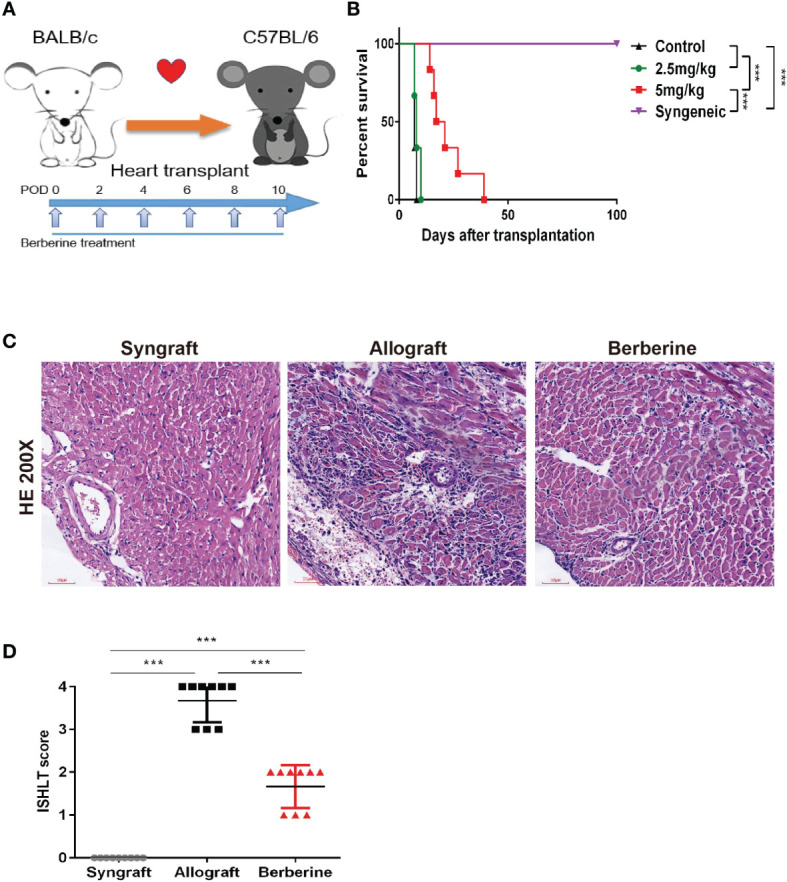
The effect of berberine on acute rejection of fully mismatched cardiac allografts. (A) Treatment schedule for berberine. BALB/c cardiac grafts were transplanted into C57BL/6 recipients at POD 0. C57BL/6 recipients were treated with normal saline, 2.5 mg/kg berberine, or 5 mg/kg of berberine i.p. on the days indicated by arrows. (B) Survival of cardiac allografts in berberine-treated and normal saline-treated mice recipients. A syngeneic transplant is shown for comparison (n = 6 mice/group). (C) HE staining of cardiac allografts collected at POD 7 from berberine-treated and normal saline-treated mouse recipients. A syngeneic graft at POD 100 is shown for comparison (scale bar = 50 μm; original magnification: ×200). (D) ISHLT grades from nine different sections from three heart allografts in each group. HE, hematoxylin and eosin; POD, post-operative day. ***p < 0.001 compared to the normal saline-treated group.